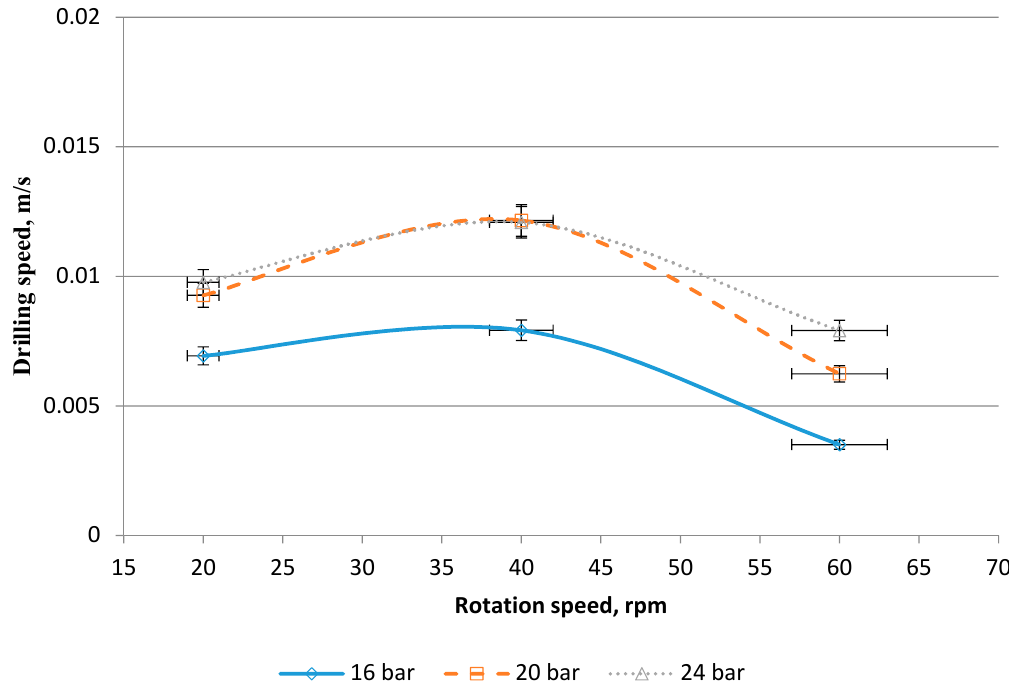
Figure 11. Variation of drilling velocity with rotation speed for several pressures (shown in the legend below the figure), for the 140 mm diameter drill bit, an interval of 54 to 72 m below the ground level, and boreholes 7–9.